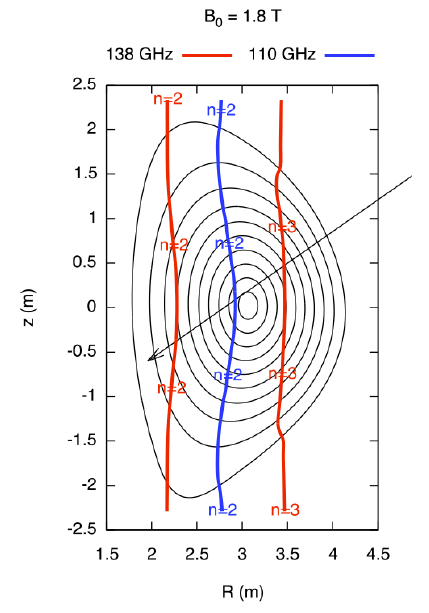
Fig. 6. EC resonances for B 0 =1.8T (cases 4,